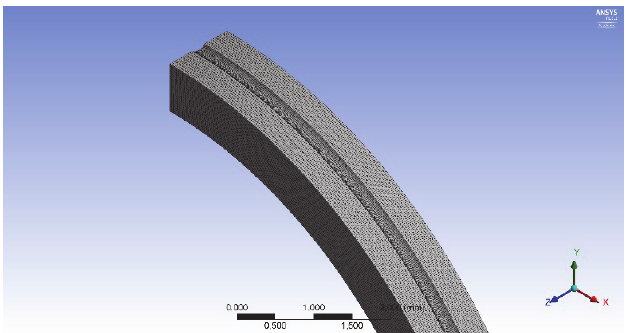
Figure 2: Submodel (finite element